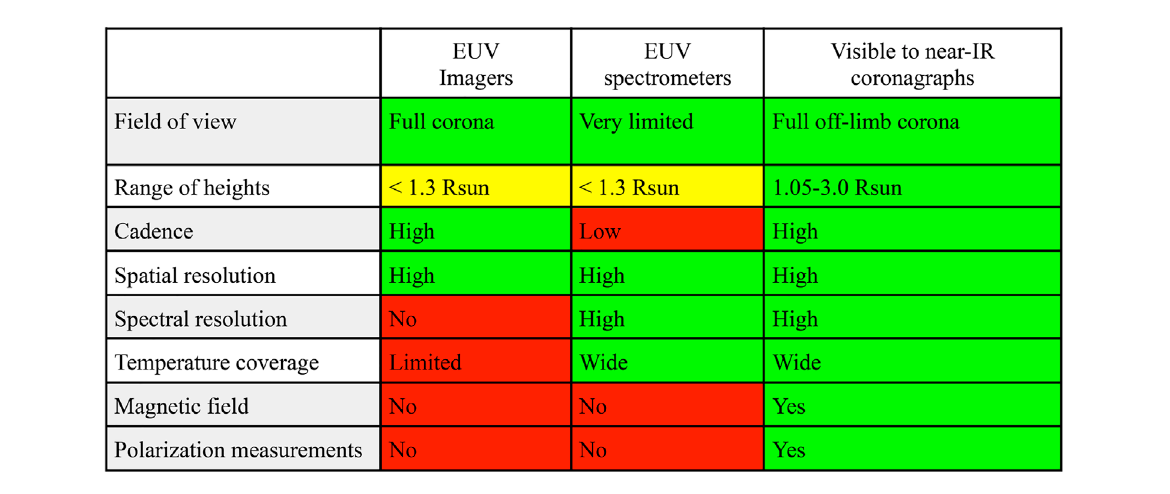
FIGURE 1 Strengths and weaknesses of available instrument types for solar coronal research. Visible to near-IR coronagraphs couple the high cadence and field of view of narrow band EUV imagers and the spectral information provided by EUV spectrometers, and further combine it with the advantages of polarized line